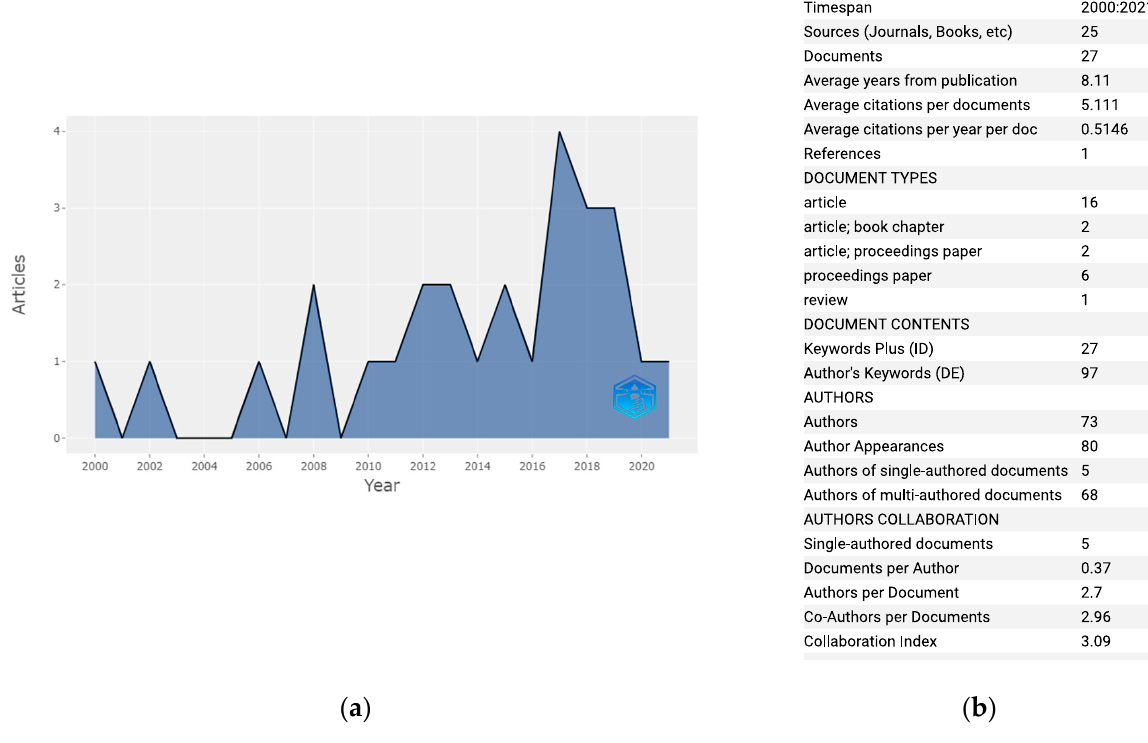
Figure 6. Bibliometric statistics of the publications on term “marine spatial data infrastructure”: ( a ) annual scientific production; ( b ) article statistics.